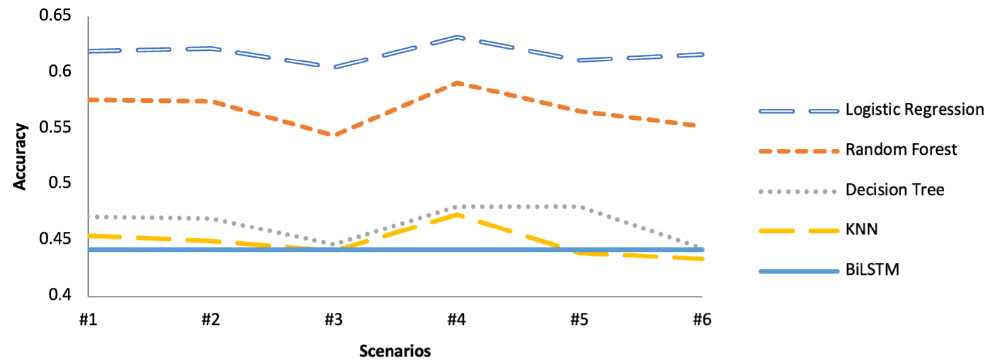
Figure 6. Algorithms’ accuracy for the classification method (Y = “Rating”).